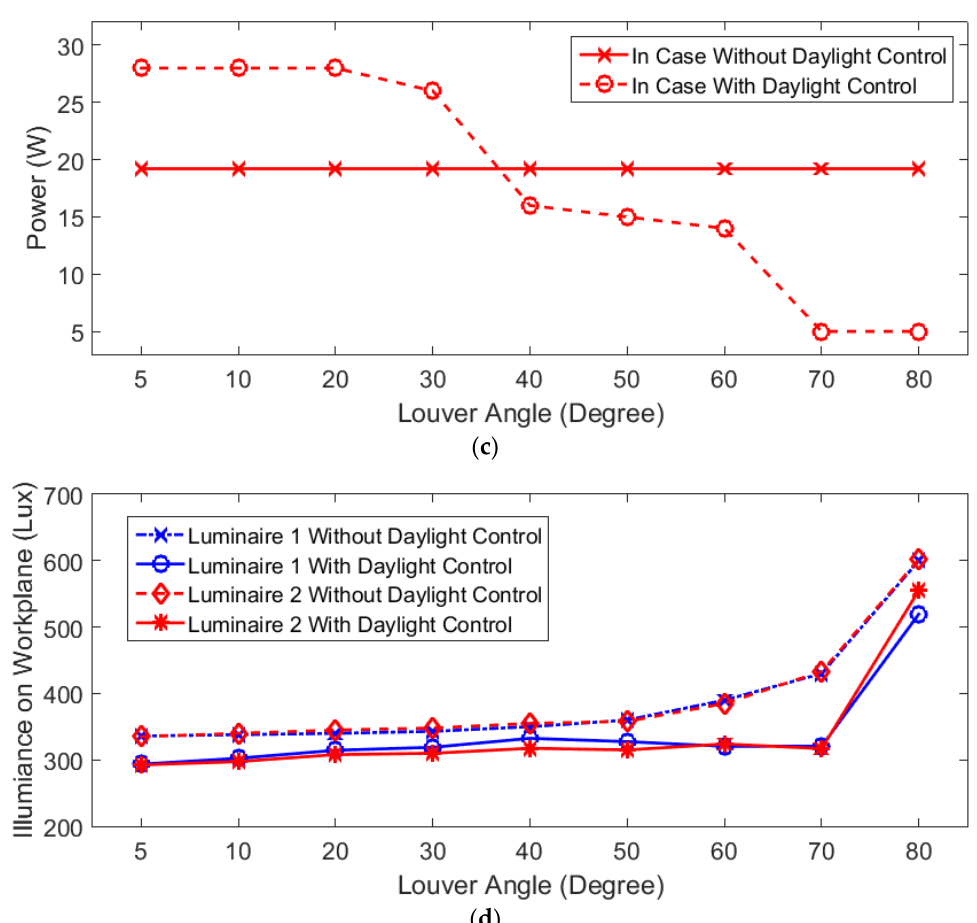
Figure 8. Effect of Louver angle on electrical and illuminance data obtained from experimental setup at 09.30 A.M.: ( a ) Voltage; ( b ) Current; ( c ) Power; ( d ) illuminance on working plane. For the actual field test at 1.00 P.M., the experiment data in terms of electrical parameters and illuminance are shown in Figure 10 with the relation between louver angle and various